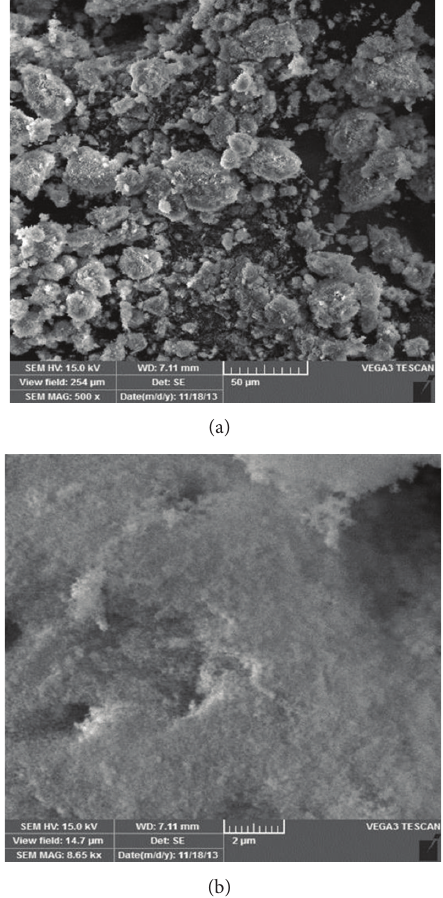
Figure 9: The SEM graph of hydroxyapatite (HA) synthesis from crab